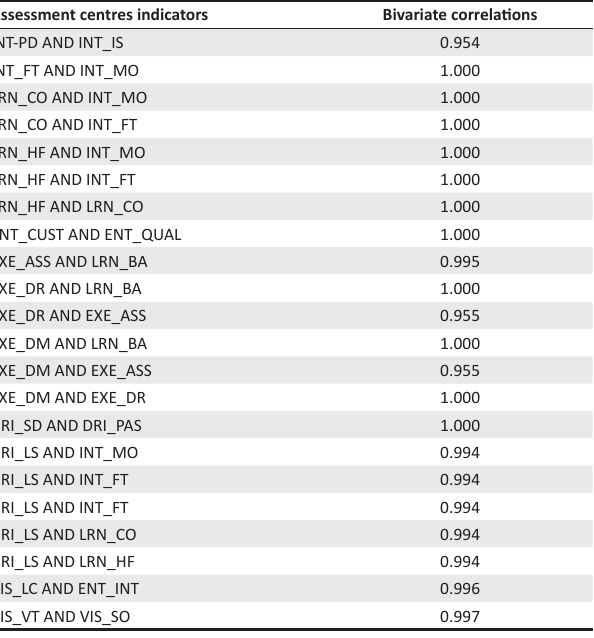
TABLE 1-A1: Bivariate correlations between assessment centres indicators. Assessment centres